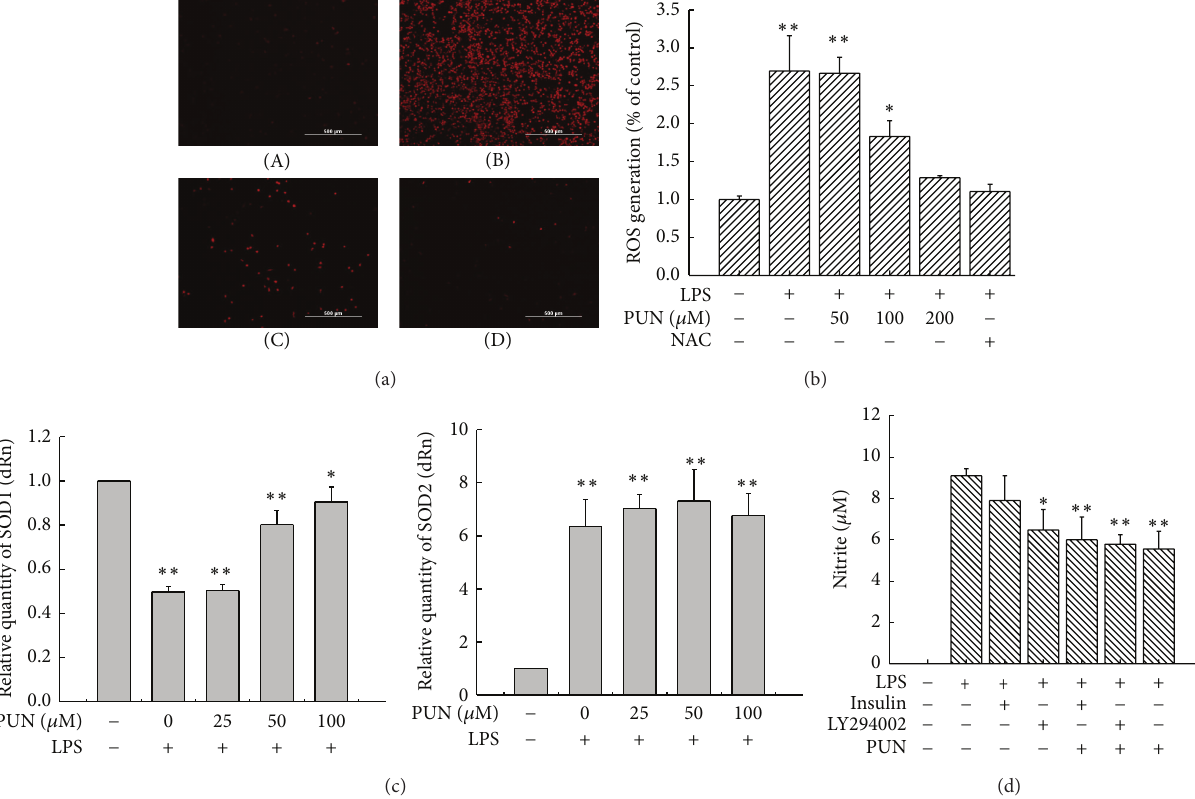
Figure 6: PUN inhibits LPS-induced oxidative stress. (a) PUN inhibits LPS-induced ROS generation. (A) RAW264.7 cells were cultured in DMEM for 12h and then incubated with probe DCFH2DA for 15min. (B) RAW264.7 cells were treated with 1 𝜇 g/mL LPS for 12 h and then incubated with probe DCFH2DA for 15min. (C) RAW264.7 cells were pretreated with 100 𝜇 M PUN for 1h before treatment with 1 𝜇 g/mL LPS for 12h and then incubated with probe DCFH2DA for 15min. (D) RAW264.7 cells were pretreated with 50 𝜇 M NAC for 1h before treatment with1 𝜇 g/mLLPSfor12handthenincubatedwithprobeDCFH2DAfor15 min.(b)ROSdetectionwasperformedbyafluorescencemicroplate reader. RAW264.7 cells were pretreated for 1h with PUN at indicated doses (0, 50, 100, and 200 𝜇 M) in the presence or absence of 100 𝜇 M NAC and before treatment with 1 𝜇 g/mL LPS for 12h and then incubated with probe DCFH2DA for 15min. (c) PUN mediated SOD1 and SOD2 mRNA expression in LPS-treated RAW264.7 cells. Cells were pretreated with PUN (25, 50, and 100 𝜇 M) and then treated to 1 𝜇 g/mL LPS for 12h; SOD1 and SOD2 mRNA expression were detected using RT-PCR. (d) PUN inhibits LPS-induced NO overproduction; RAW264.7 cells were pretreated for 1h with or without 100 𝜇 M PUN in the presence or absence of indicated inhibitor (LY294002, 20 𝜇 M) and inducer (insulin, 10 𝜇 M) before treatment with 1 𝜇 g/mL LPS for 12h. NO production in the supernatant was measured using Griess reaction. Data represent the mean ± SEM of three independent experiments and differences between mean values were assessed by one-way ANOVA. ∗ 𝑃 < 0.05 , ∗∗ 𝑃 < 0.01 , △ 𝑃 < 0.05 , △△ 𝑃 < 0.01 , # 𝑃 < 0.05 , and ## 𝑃 < 0.01 indicate significant differences compared with the control group of indicated proteins,